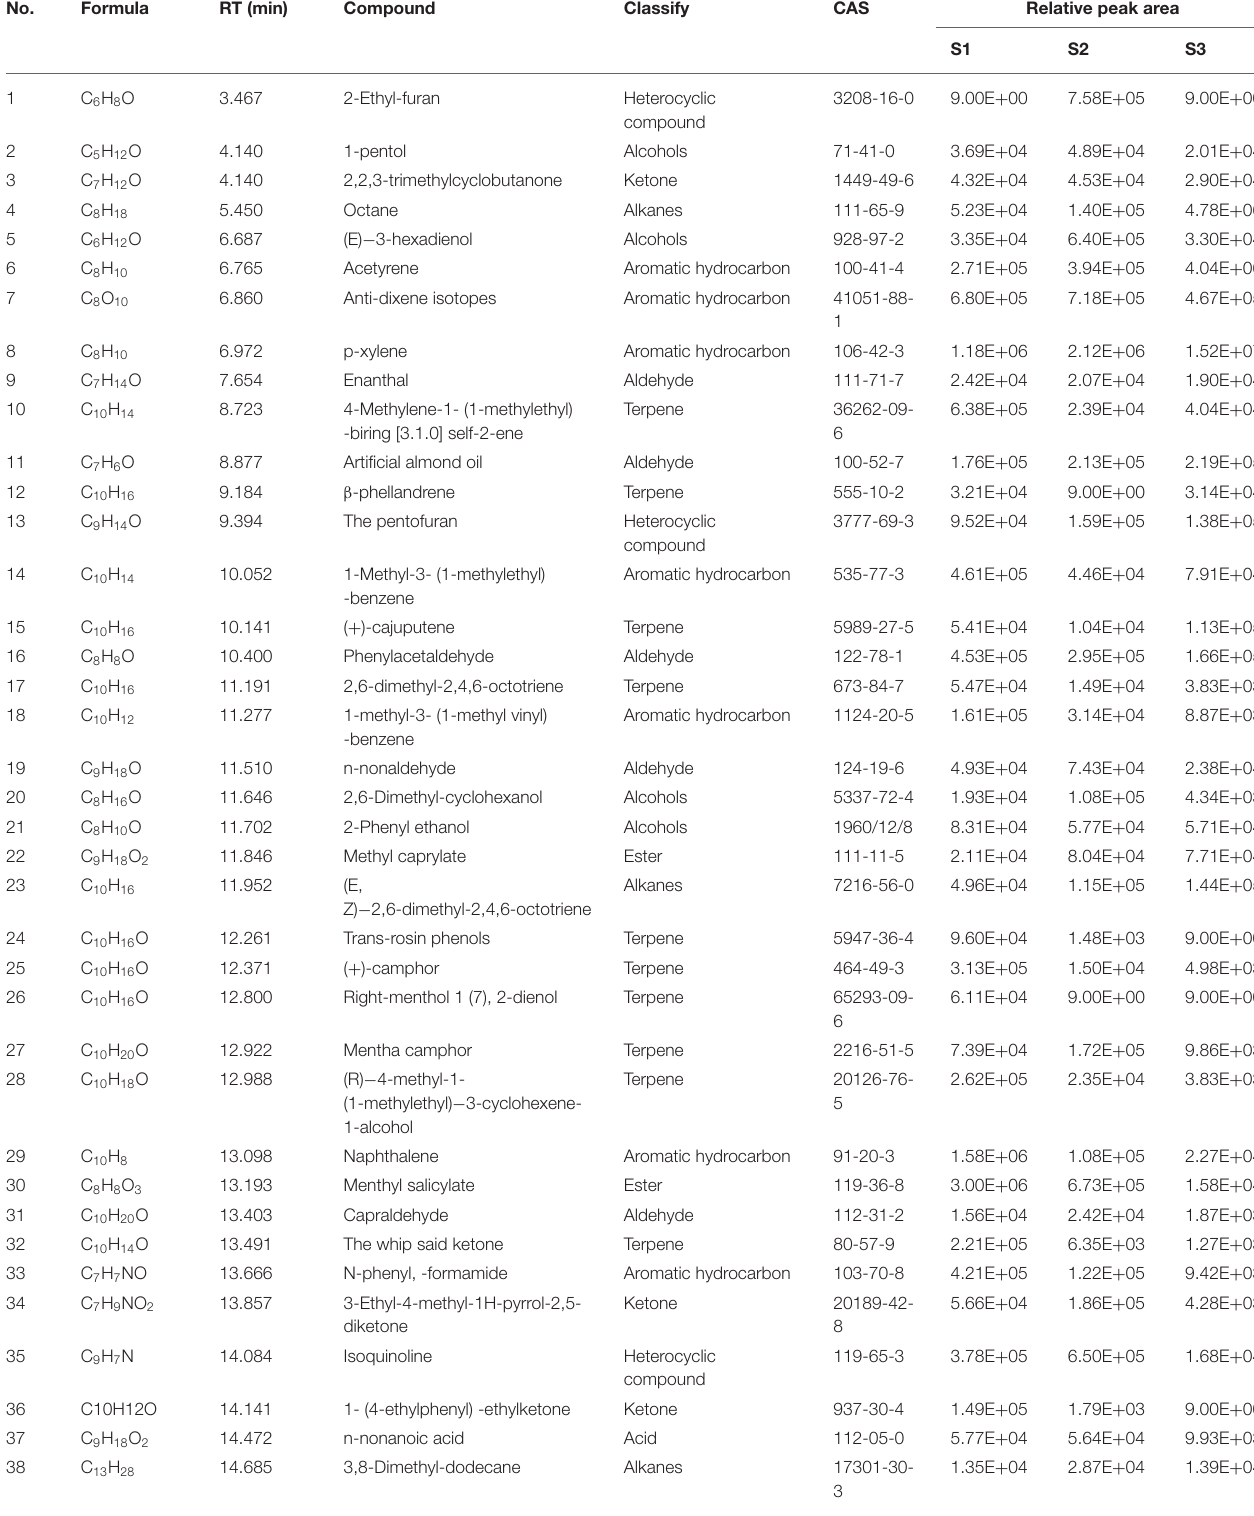
TABLE 2 | Information of volatile chemical constituents of different samples of P. harmala L.